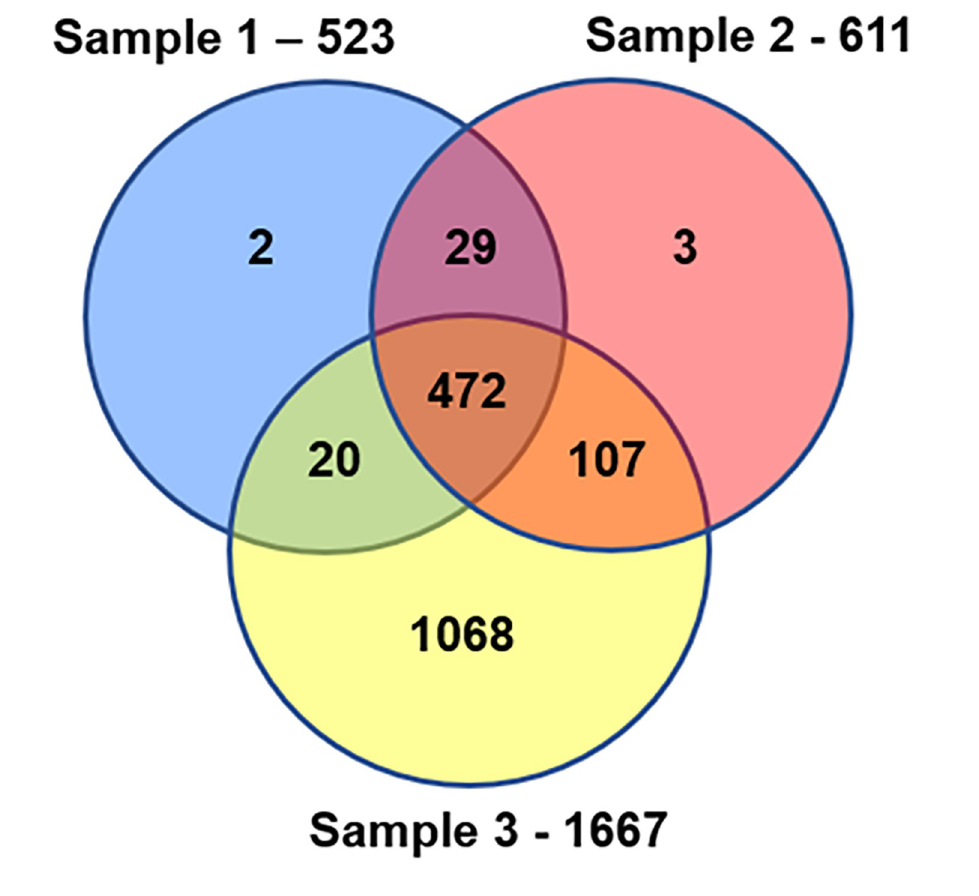
Fig 1. Distribution of unique protein identifications across three Culex sperm proteome